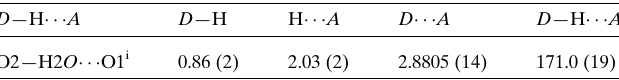
Table 1 Hydrogen-bond geometry (A˚ , (cid:2) ).